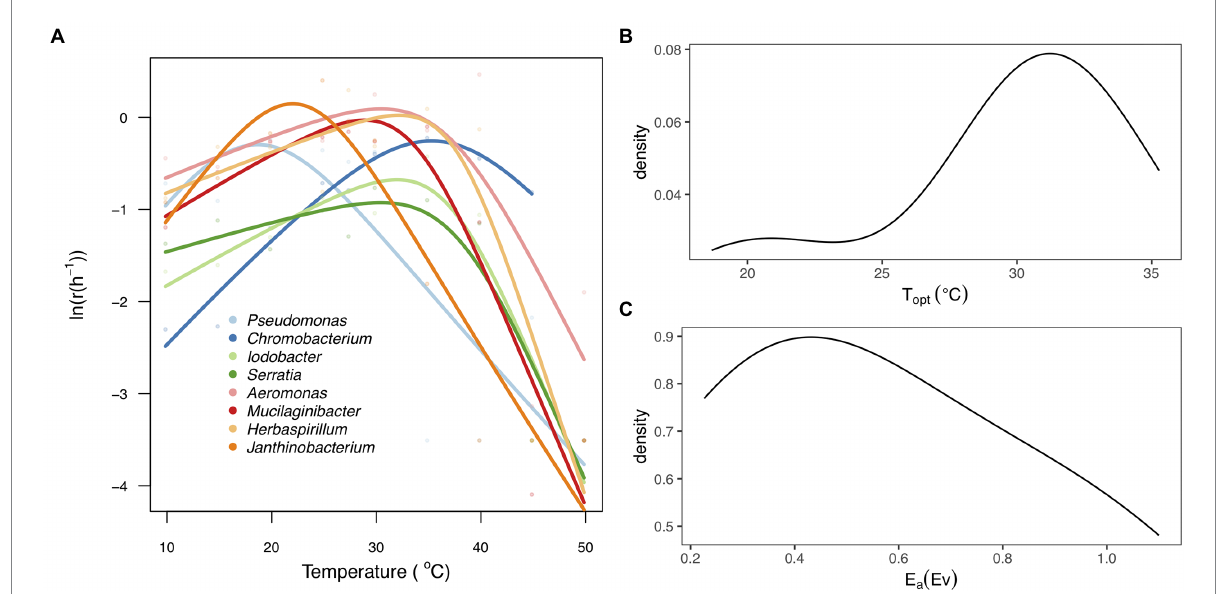
FIGURE 2 Thermal tolerance curves for the eight bacteria taxa. (A) Fitted thermal tolerance curves of population growth rate [ln( r (T))] for each of the eight taxa analyzed using the Sharpe-Schoolfield equation (Materials and methods). Different colored lines represent the taxa and different colored points represent the mean values of the technical replicates per taxa and temperature. (B) Probability density plot representing the distribution of thermal optimum temperature ( T opt ). (C) Probability density plot showing variation in the activation energy ( E a ) between the eight